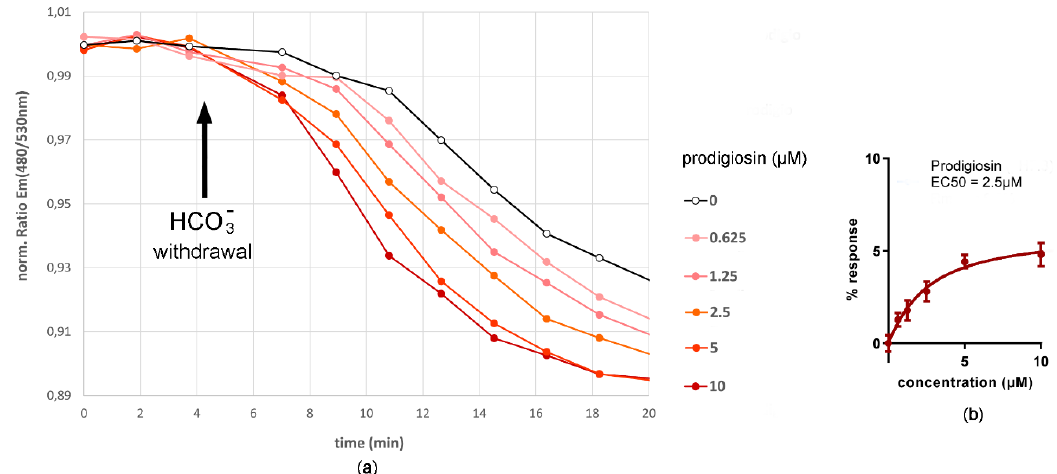
Figure 11. Bicarbonate efflux assay - bicarbonate transport activity of prodigiosin. The bicarbonate